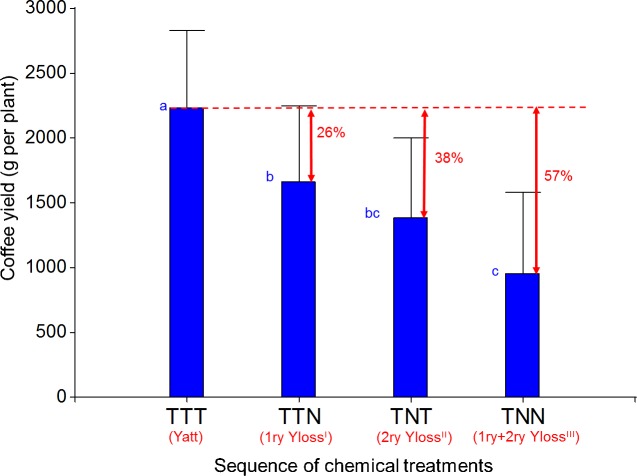
Yields and primary and secondary yield losses resulting from the sequences of chemical treatments TTT, TTN, TNT, TNN.T: treated with pesticides; N: no control of pests and diseases. Different lowercase letters between bars indicate significant differences (P<0.05) between coffee yields. Red arrows and numbers in percentages represent the yield losses. Yatt: attainable yield; Yloss: coffee yield loss; I: primary losses resulting from the current-year injuries (year n); II: secondary losses resulting from year n-1 injuries; III: primary and secondary losses (total losses) resulting from years n and n-1 injuries.